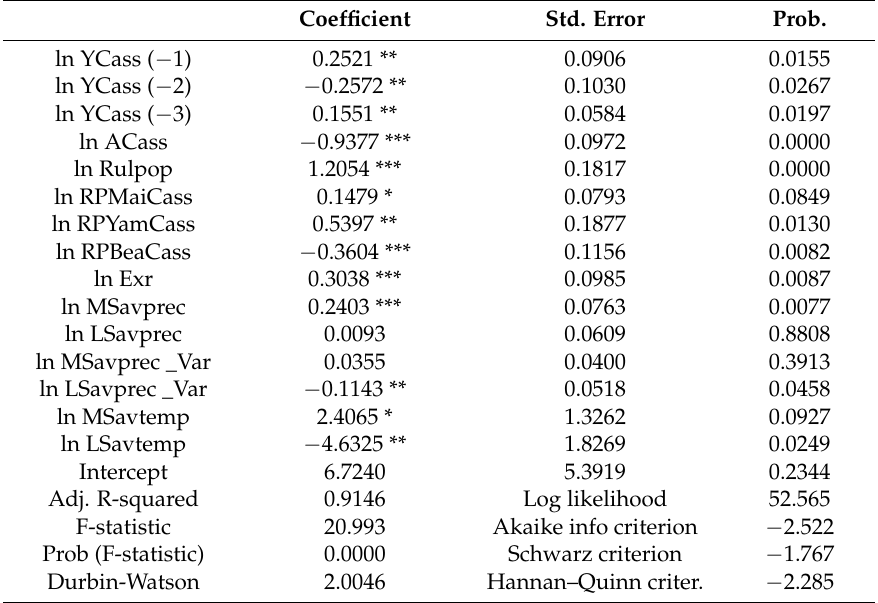
Table A3. Estimation equation (base model). Selected ARDL (3,0,0,0,0,0,0,0,0,0,0,0,0); Maximum dependent lags:3 (Automatic selection); Model selection method: Schwarz criterion (SIC); Trend specification: Unrestricted intercept; Included Observations: 29 after adjustments. Coefficient Std.